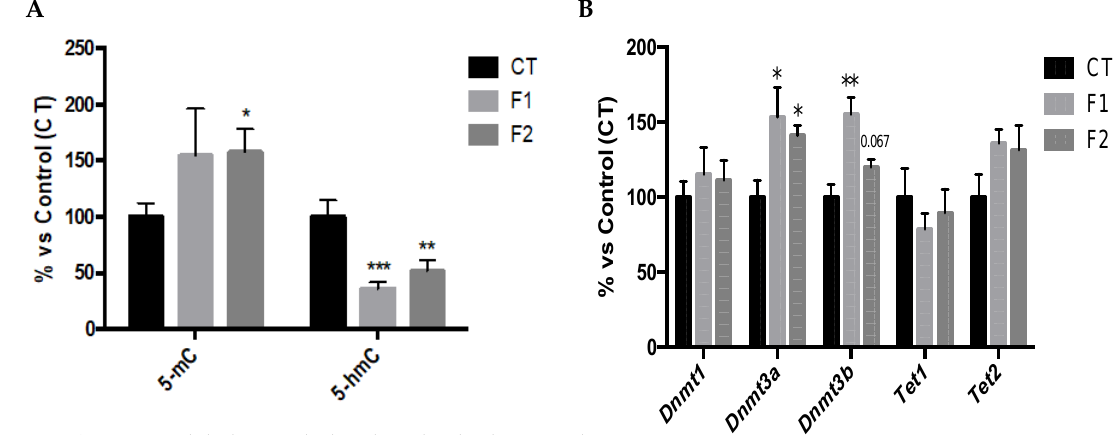
Figure 3. Global 5-methylated and 5-hydroxymethylated cytosine levels in the hippocampus of females and males at 6 months of age for all mice groups ( A ). Relative gene expression of Dnmt1 , Dnmt3a, Dnmt3b, Tet1 , and Tet2 ( B ). Gene expression levels were measured by real-time polymerase chain reaction (PCR) from hippocampal mRNA. Mean ± SEM in bar graphs are adjusted to 100% for each gene of CT group; n = 18 to 21 (CT n = 6 to 7, F1 n = 6 to 7, F2 n = 6 to 7; for each group, females 3 to 4, males n = 3). Statistics: * p < 0.05; ** p < 0.01; *** p < 0.001.